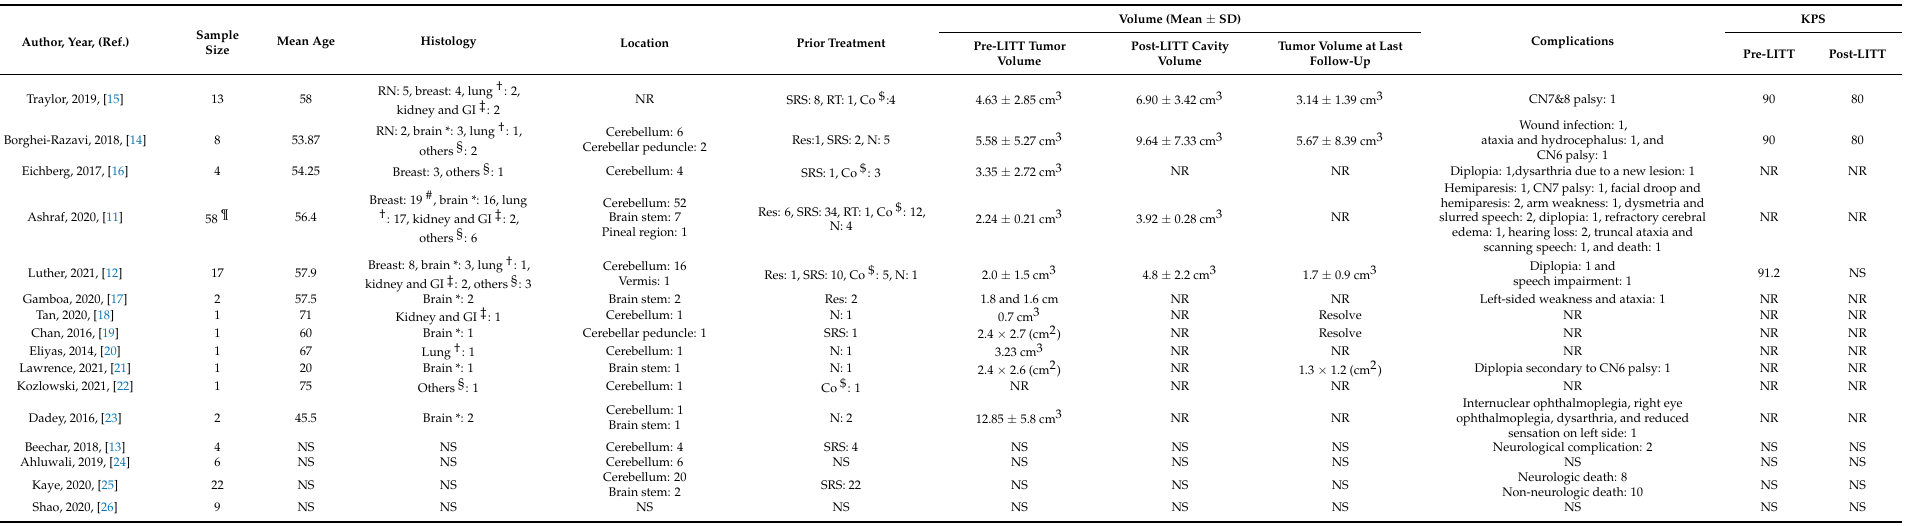
Table 1. LITT on posterior fossa